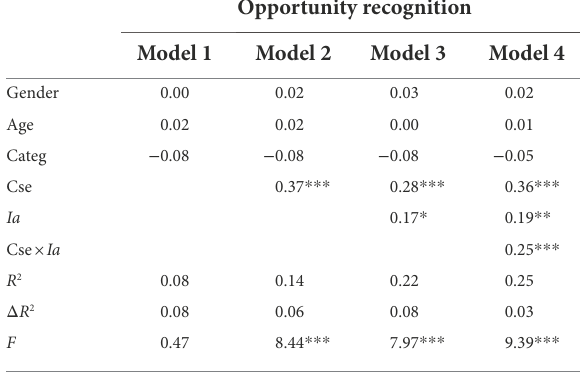
TABLE 7 Results of the moderating effects of support for